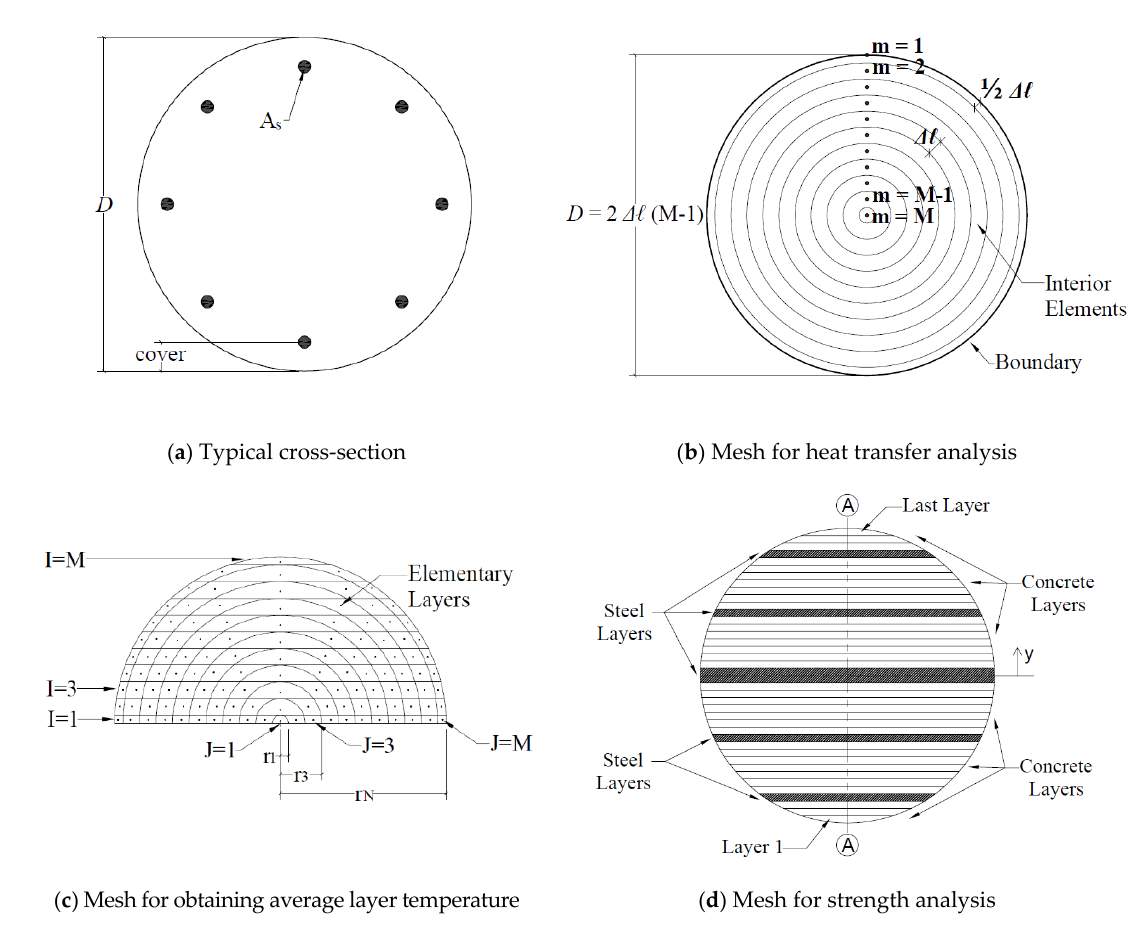
Figure 5. Geometry and meshing of circular sections.